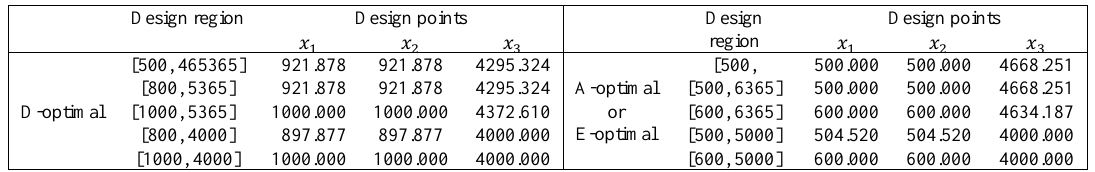
Table 13. D-, A- and E-optimal designs for generalized Pareto model with three support points having